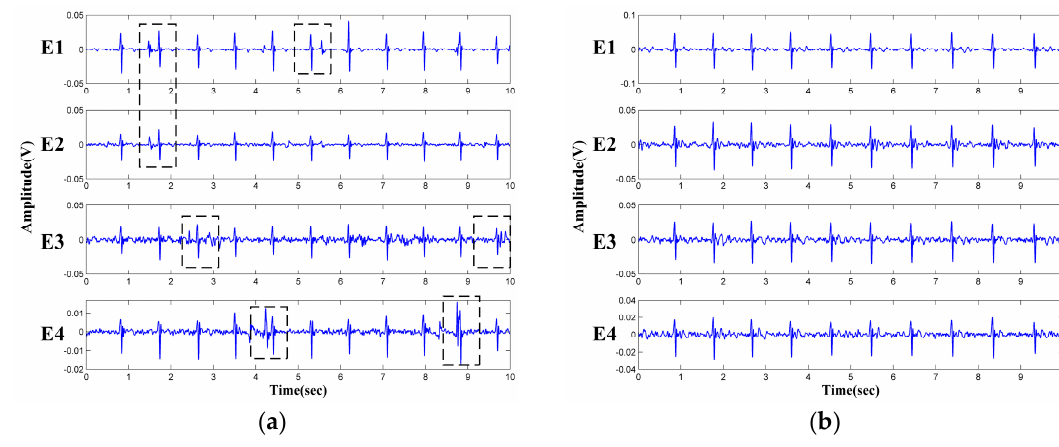
Figure 9. ECG signals obtained under different backrest: ( a ) Firm configuration; ( b ) Soft configuration.